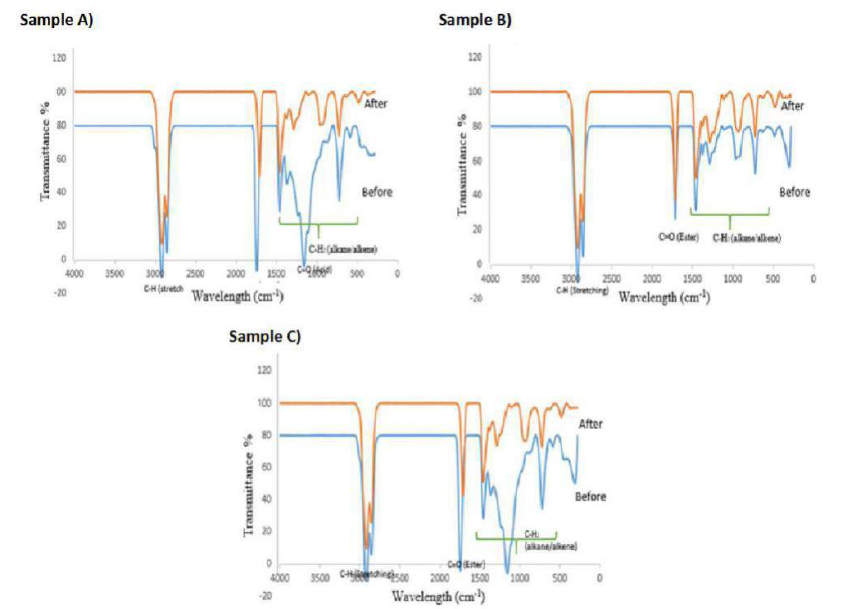
Figure 4. FTIR spectra of the deoxygenated sample ( A – C ) liquid product catalysed.